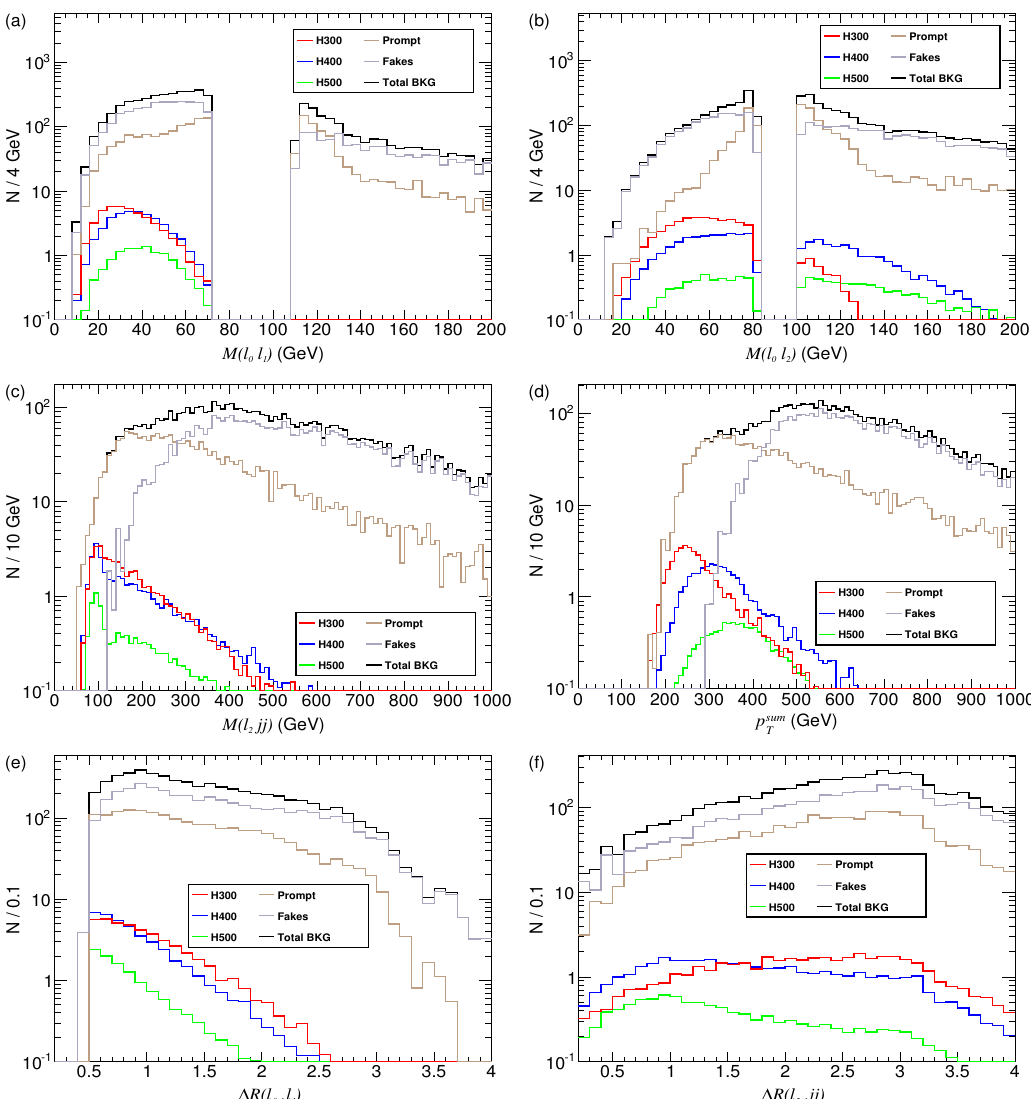
Figure 8 . Distributions of di(cid:11)erent kinematical variables in the 3L decay channel: (a) invariant mass of ‘ 0 and ‘ 1 , (b) invariant mass of ‘ 0 and ‘ 2 , (c) invariant mass of ‘ 2 and selected jets, (d) linear p T sum of two leptons, selected jets and transverse missing energy, (e) (cid:1) R distance of ‘ 0 and ‘ 1 , (f) (cid:1) R distance of ‘ 2 and selected jets system. For these plots, we input an integrated luminosity of 300fb (cid:0) 1 .